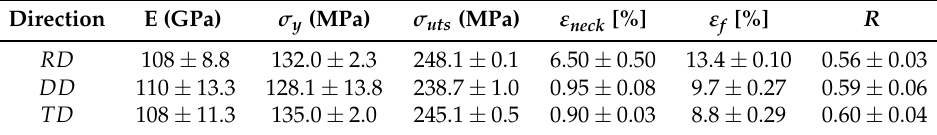
Table 1. Experimentally measured values for the RD, DD, and TD tensile samples.